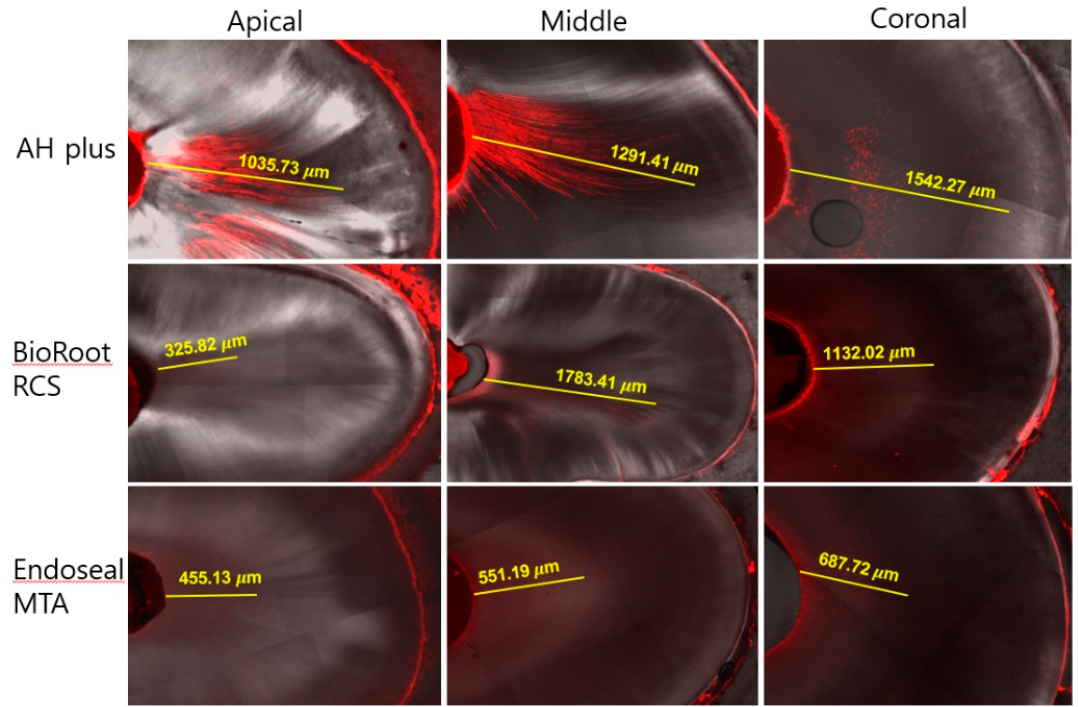
Figure 6. Representative image of the maximum sealer penetration of all experimental sealers in the apical, middle, and coronal thirds.